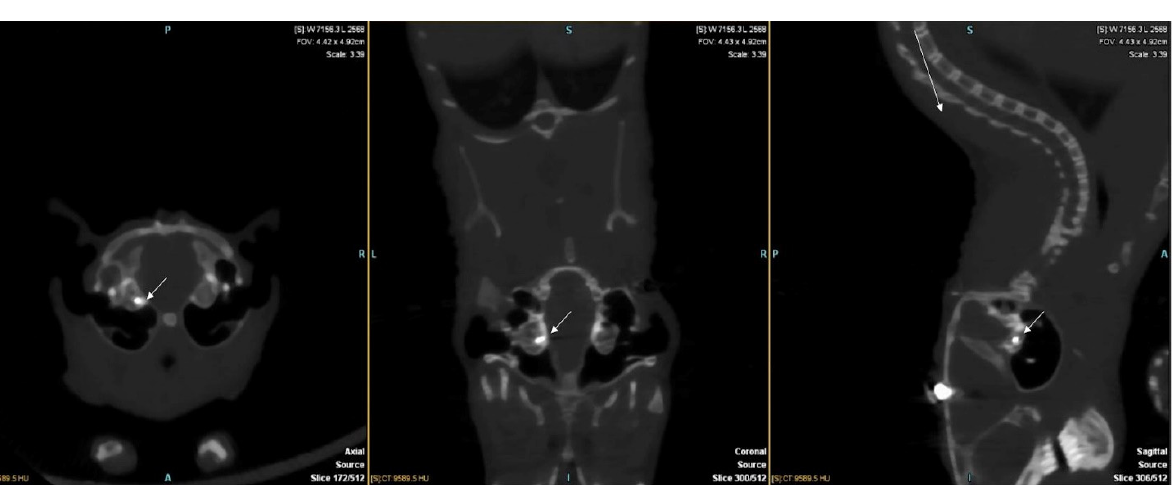
Figure 1. Axial, coronal, and sagittal slice reconstruction of a gerbil’s CT scans at 10 weeks after implantation. The 2 electrodes are visualised in the right cochlea (arrows).